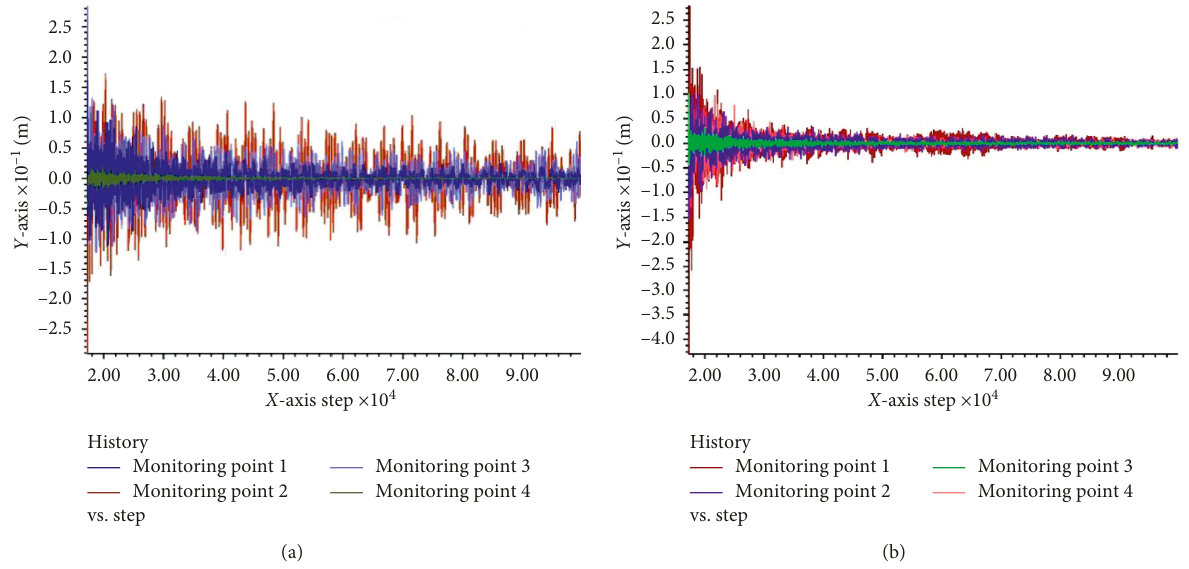
Figure 9: Deformation velocity response diagrams for six dynamic loads. (a) X -directional deformation velocity and (b) Z -directional deformation velocity.